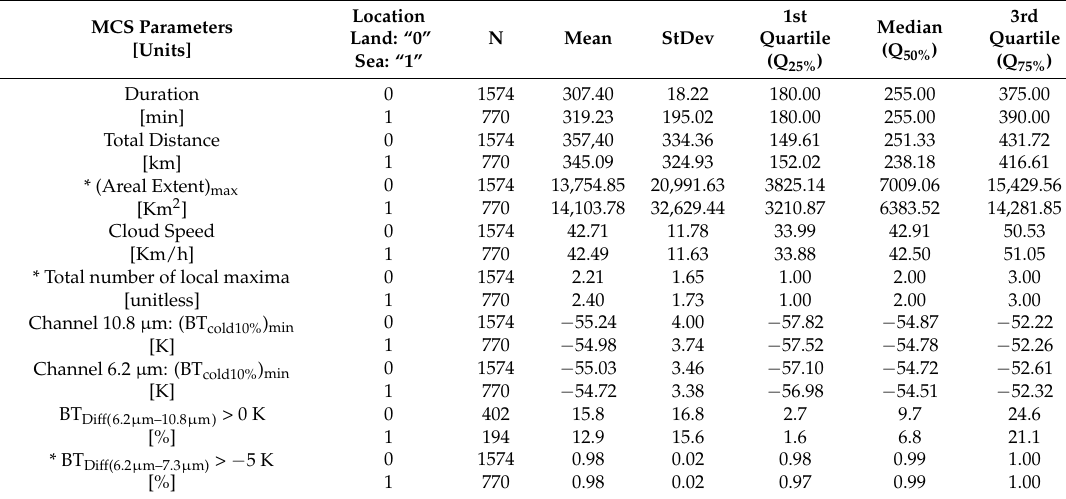
Table 7. Basic descriptive statistics for the number of MCSs with at least one CC localmax event which first occurred over land and sea. The values of the parameter “BT Diff(6.2 µ m–10.8 µ m) ” refer only to the number of MCSs where at least one cloud cell during an MCS lifecycle fulfills this criterion “BT Diff(6.2 µ m–10.8 µ m) > 0 K” (596 MCS out of 2344 in total). The asterisk (“*”) represents statistically significant differences of the mean values (95% statistical confidence